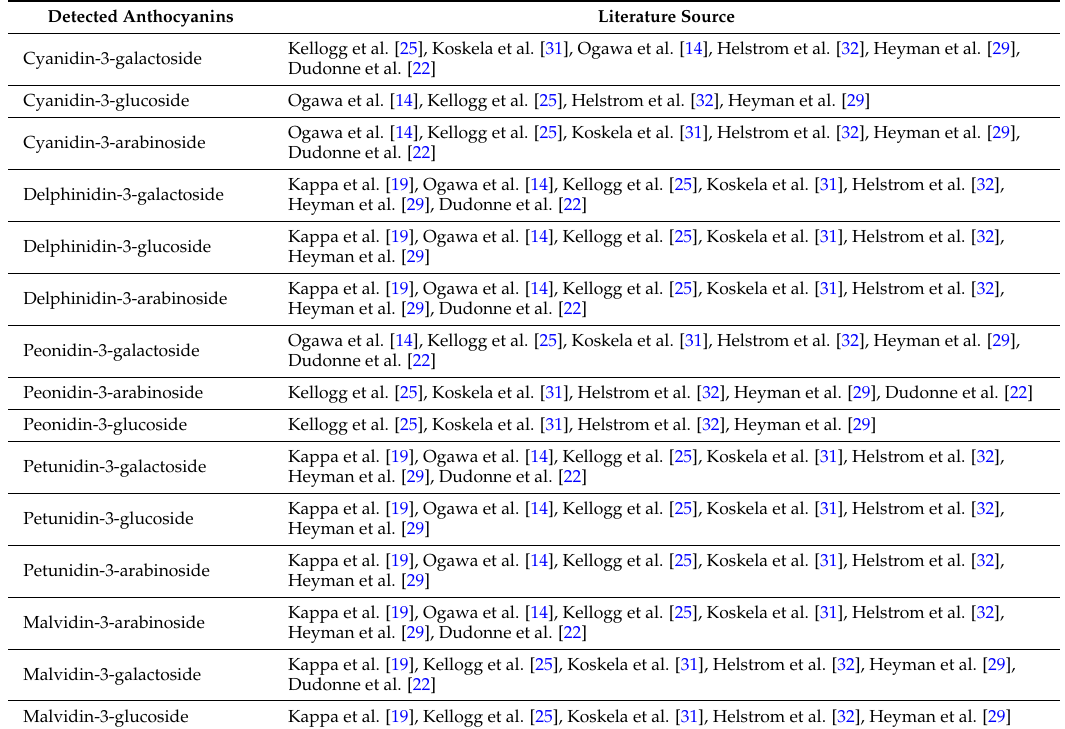
Table 2. Anthocyanins in Empetrum nigrum